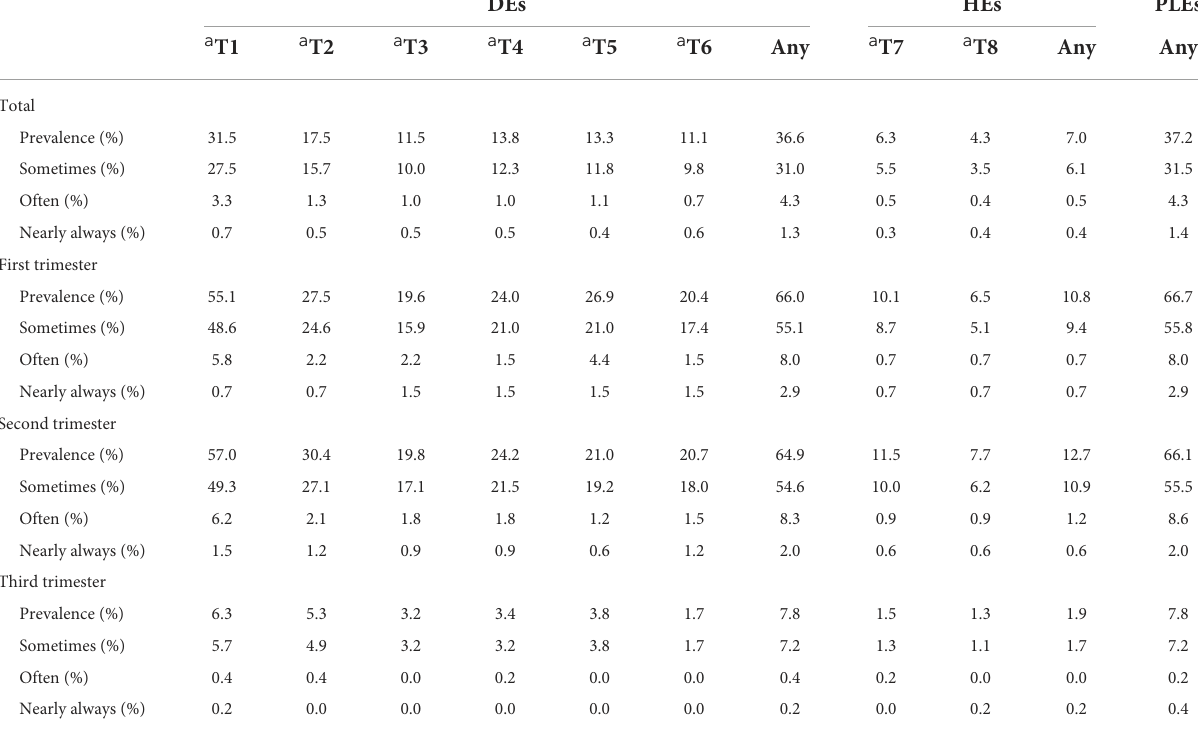
TABLE 2 Frequency of each item in eight items of positive dimensions of the community assessment of psychic experiences (CAPE) and prevalence of different psychotic-like experiences (PLEs) among pregnant women. DEs HEs